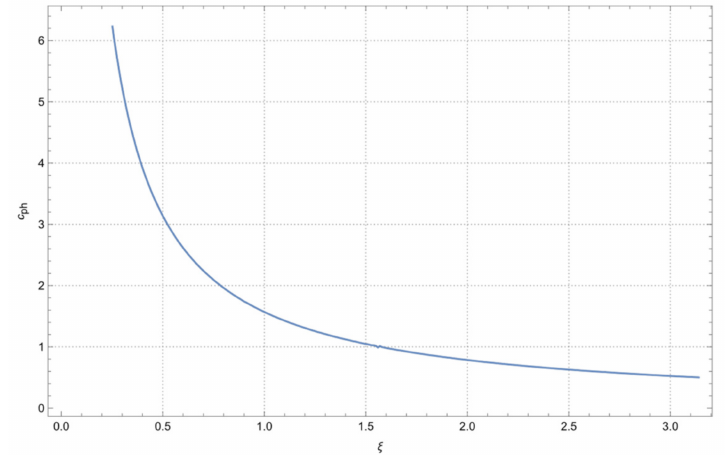
Figure 3. Phase velocity as a function of the wavenumber for monodisperse k 1 = k 2 = 0.5; k 3 = k 4 = 0 and polydisperse k 1 = k 2 = 0.4; k 3 = k 4 = 0.1 phononic crystals. The graphs match.